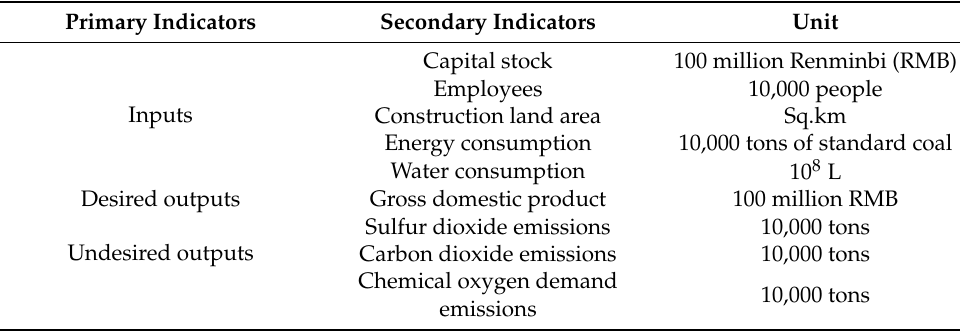
Table 1. Evaluation index system of